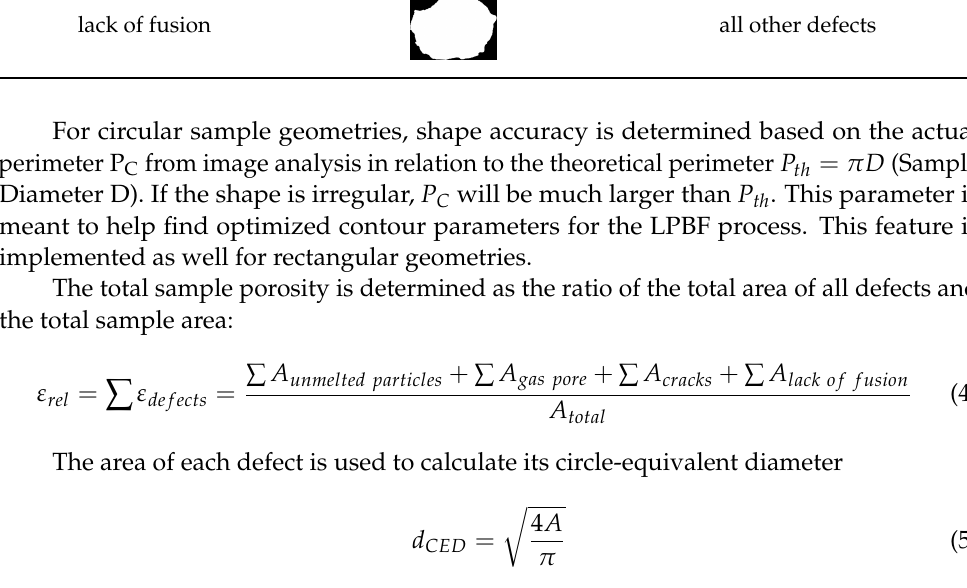
Table 4. Size classes used for the calculation of the pore size distribution.